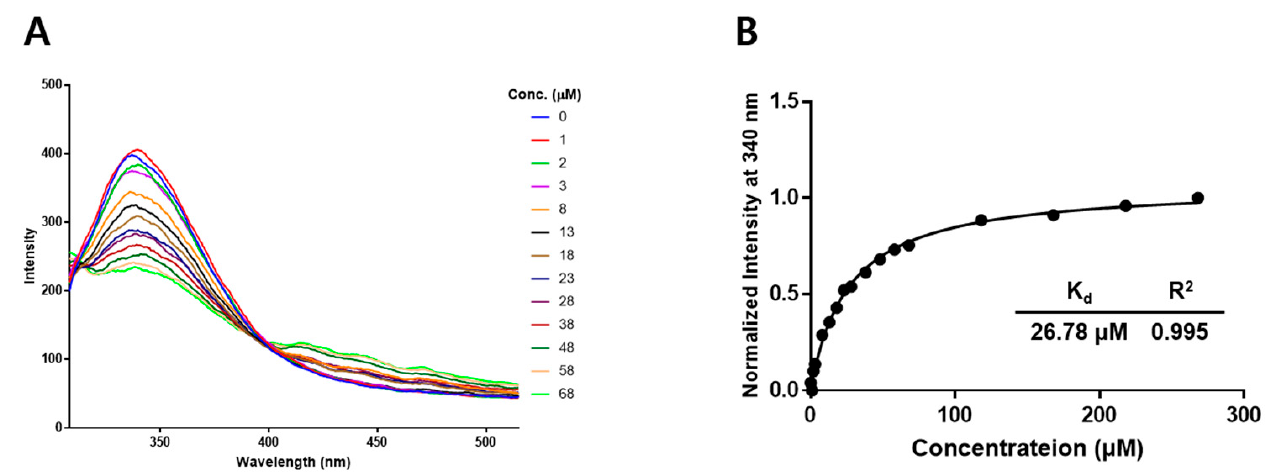
Figure 1. Fluorescence-based binding titration measurements of SKSI-0412 (4) to STAT3. Protein samples were excited at 280 nm, and the decrease in fluorescence emission upon binding was measured at 340 nm. A dose-dependent decrease in fluorescence emission versus wavelength ( A ) and calculation of dissociation constant (Kd) via normalized inhibition of fluorescence intensity at 340 nm ( B ) were demonstrated.